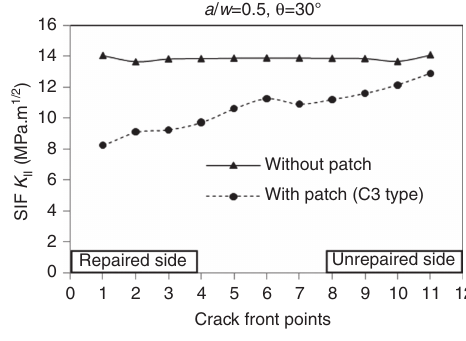
Figure 22 Effect of patch on K